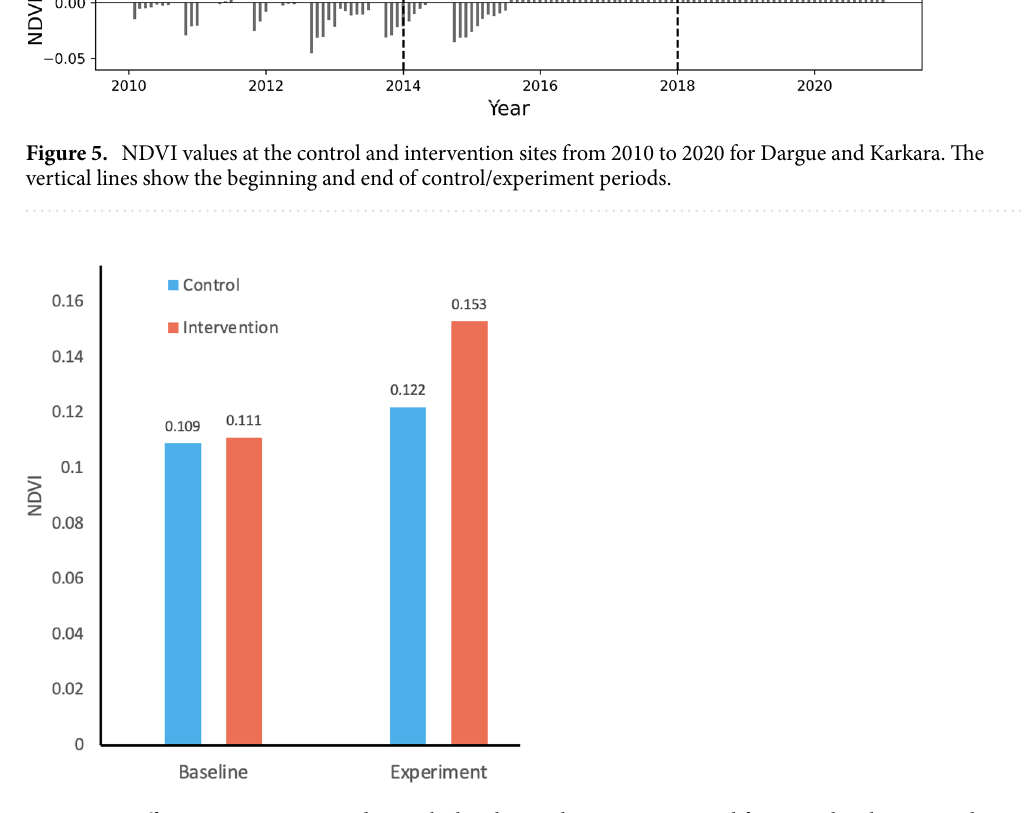
Figure 6. Difference in mean NDVI during the baseline and experiment period for control and intervened